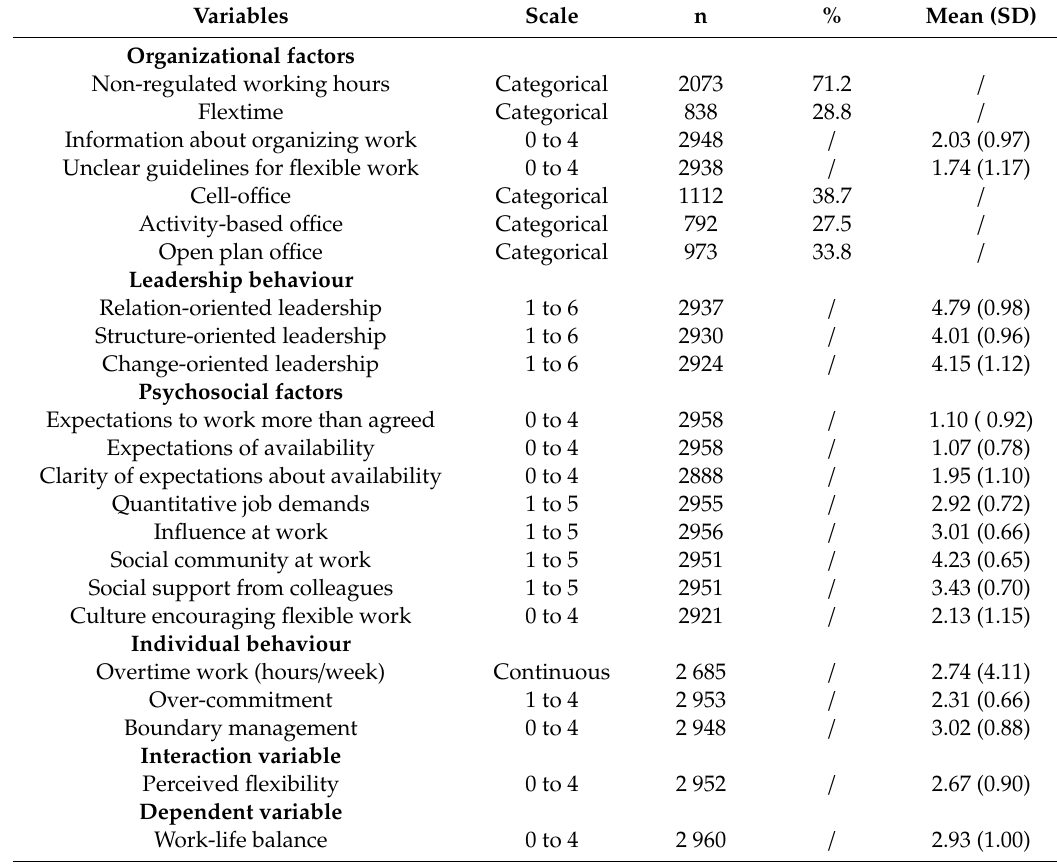
Table 2. Mean and SD between participants of work-life balance (WLB), perceived flexibility, occupational factors, and individual behaviours, (n, number of participants to the question or index, cf. Table 1; %, n in percent of